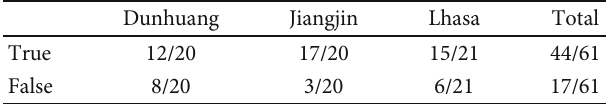
Table 9: Classi fi cation accuracy of the experimental regions for various incomplete data areas.